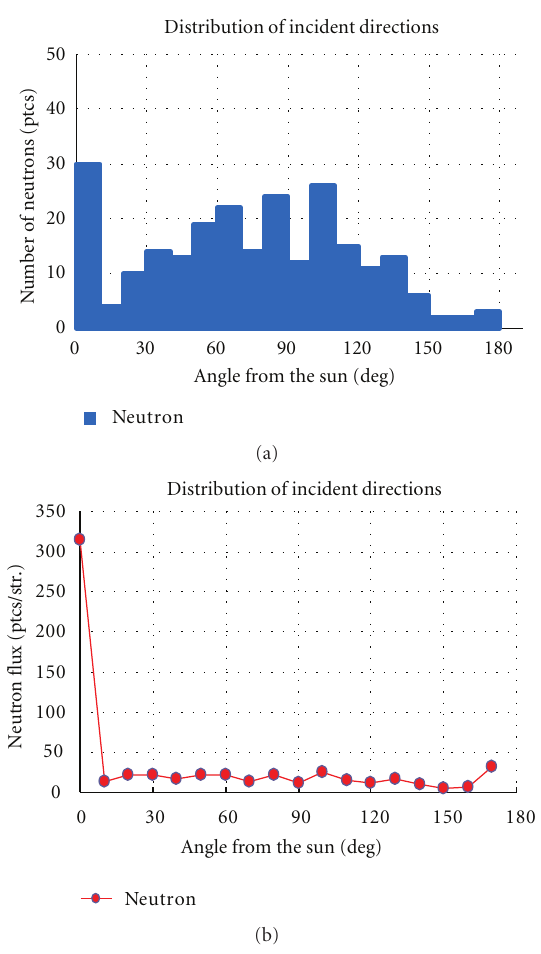
Figure 14: (a) The angular distribution of neutrons detected by the FIB sensor during 06:20 UT and 06:41 UT on June 7, 2011. Total number of neutrons detected above duration was 240. (b) The histogram of (a) is divided by the solid angle. The vertcical axis represents dN/d Ω . A sharp peak is recognized at the solar direction, while beyond 10 degrees, almost flat distribution is